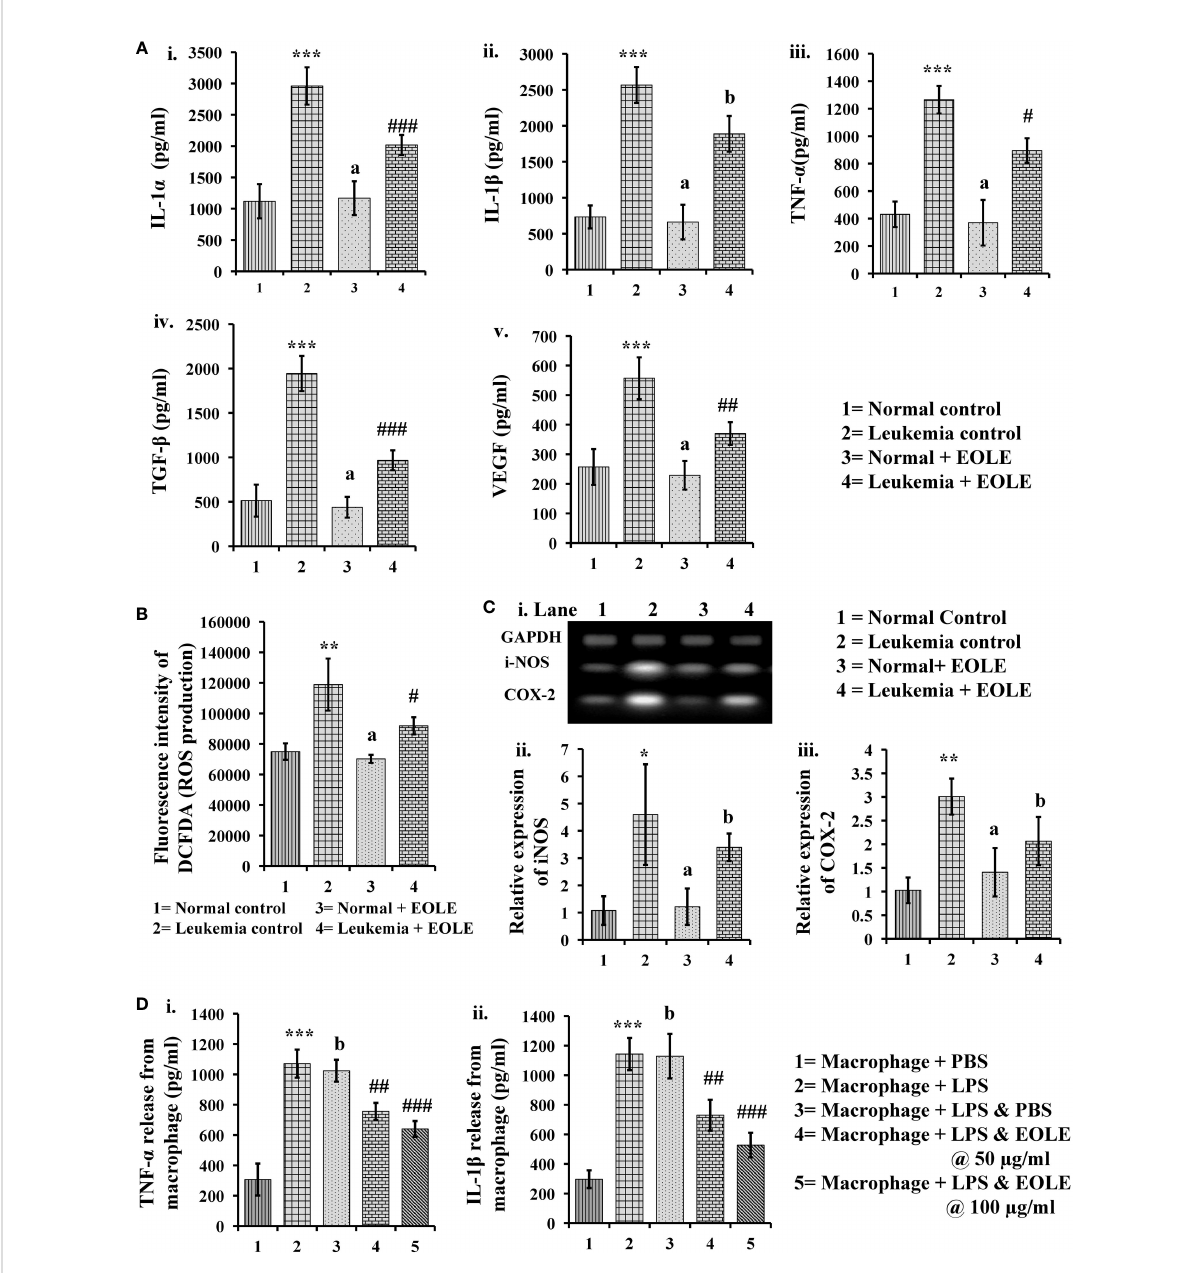
FIGURE 6 Figures showing the result of EOLE treatment on the expression of various in fl ammatory substances: (A) Bar diagrams showing the concentrations of various in fl ammatory cytokines in BM, where (i) IL-1 a , (ii) IL-1 b , (iii) TNF- a , (iv) TGF- b , (v) VEGF; (B) ROS production by the BM cells; (C) Result of gene expression studies, where (i) Bands of PCR ampli fi ed products, (ii) Relative expression of iNOS, (iii) Relative expression of COX-2; values are expressed as mean ± SD of 3 different observations. The statistical signi fi cance was tested using one-way ANOVA following Tukey ’ s multiple comparison tests by comparing the values as, Group-1 vs . Group-2, 3; Group-2 vs . Group- 4. P value, p < 0.05 was considered as statistically signi fi cant. When compared with Group-1 the level of signi fi cance was denoted as, a = not signi fi cant when p > 0.05; * when p < 0.05; ** when p < 0.01; and *** when p < 0.001. When compared with Group-2, b = not signi fi cant when p > 0.05; # when p < 0.05; ## when p < 0.01; and ### when p<0.001; (D) Bar diagrams representing the result of macrophage in fl ammation assay, where (i) TNF- a release, (ii) IL-1 b release; values are expressed as mean ± SD of 3 different observations. The statistical signi fi cance was analyzed by comparing the values as, Group-1 vs . Group-2; Group-2 vs . Group- 3, 4, 5. P value, p < 0.05 was considered as statistically signi fi cant. When compared with Group-1, a = not signi fi cant when p > 0.05; * when p < 0.05; ** when p < 0.01; and *** when p < 0.001. When compared with Group-2, b = not signi fi cant when p > 0.05; # when p < 0.05; ## when p < 0.01; and ### when p <